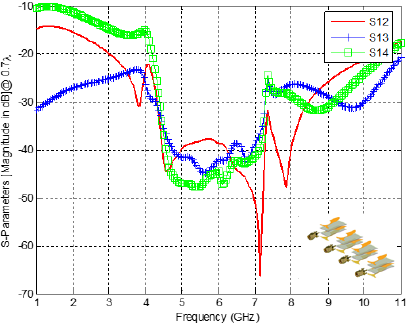
FIGURE 15. Parametric study of the broadband mutual coupling for different values of inter-element distance (0.7 λ ) (8 antennas